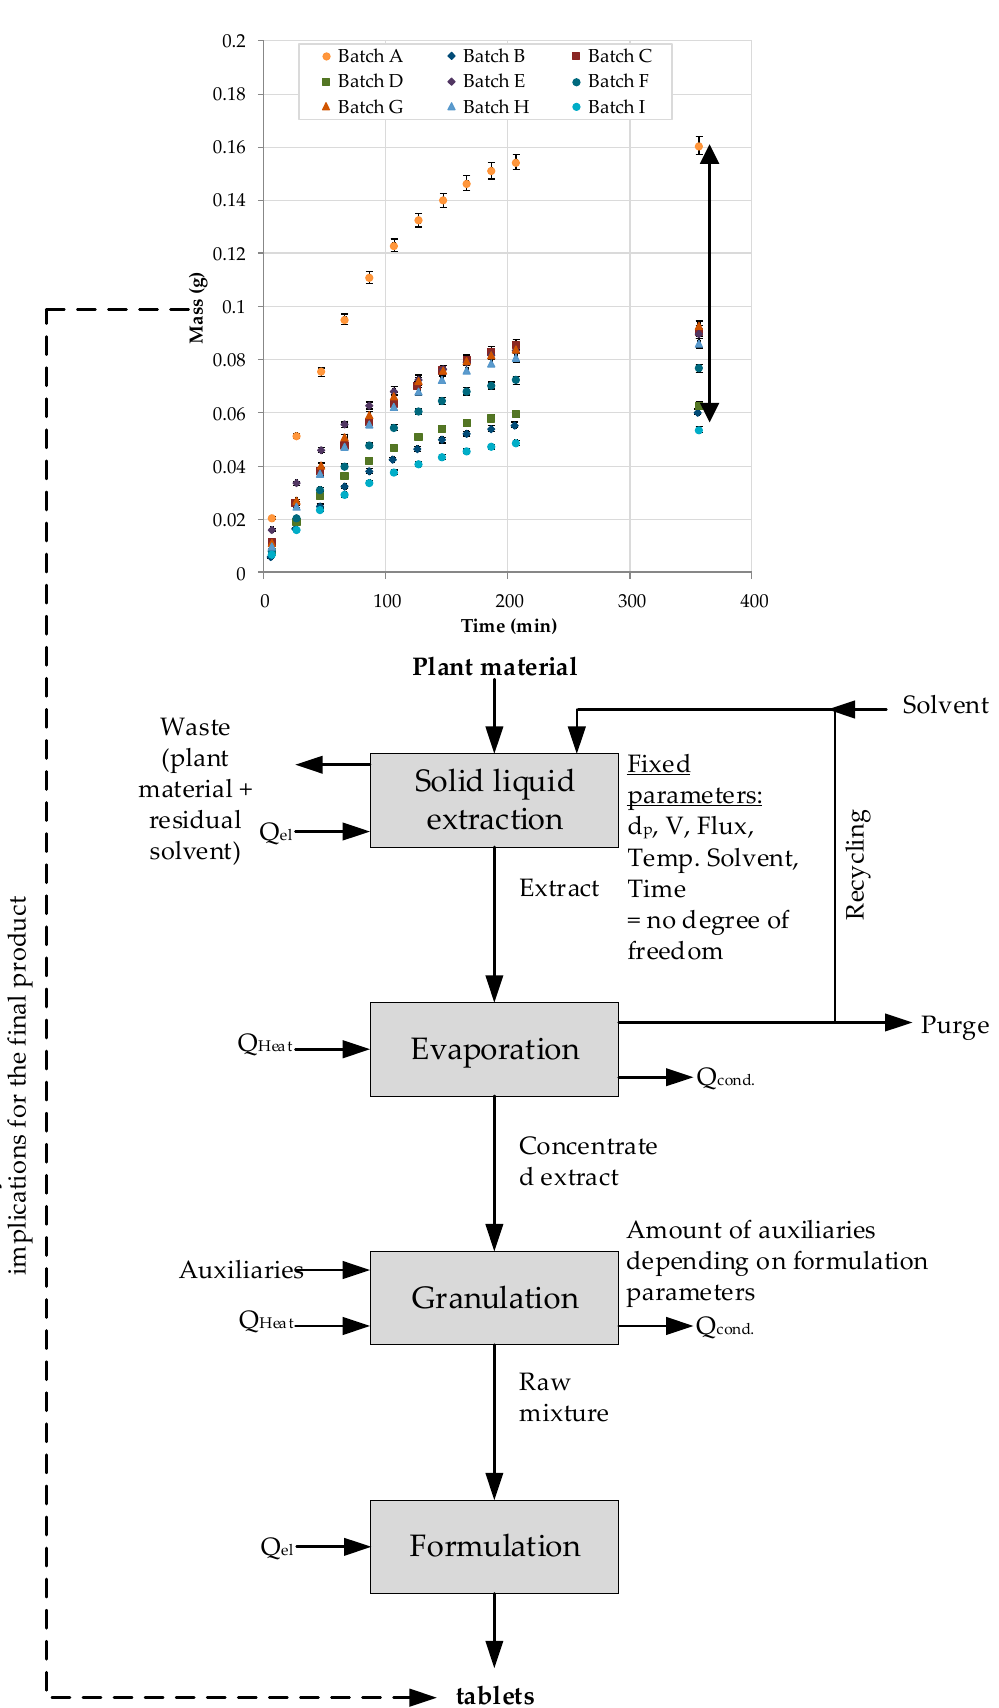
Figure 3. Basic scheme of phytoextraction processes [50].